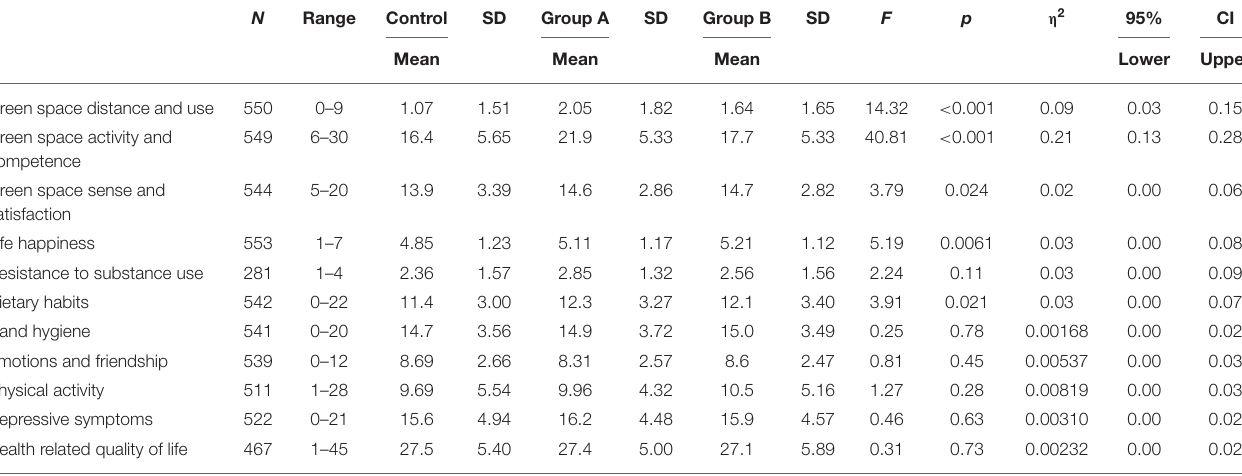
F, F-value of ANOVA. η 2 , eta-squared.